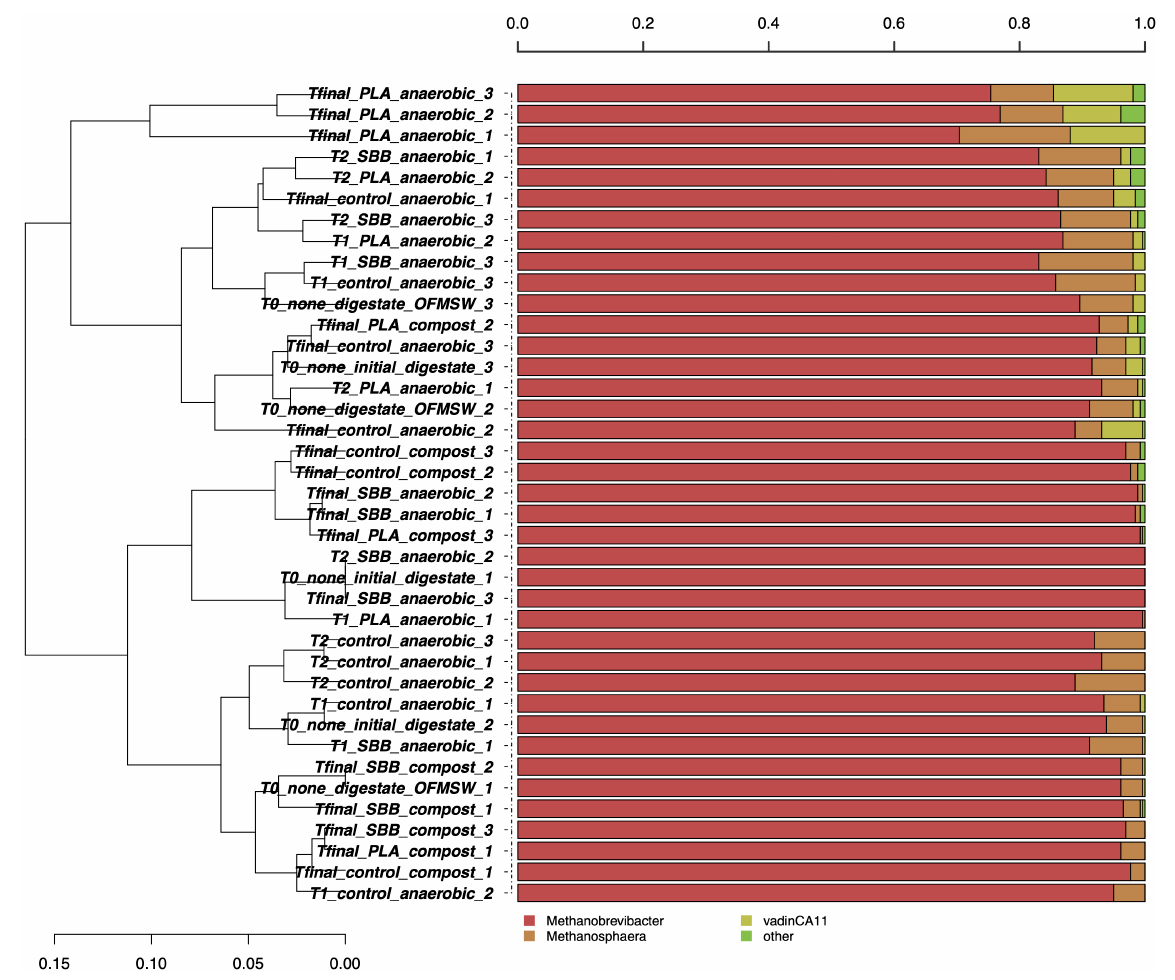
FIGURE2 Hierarchical clustering of archaeal sequences using the average linkage algorithm at the genus level for taxa with at least ≥ 5% participation in a single sample. Taxa with low contributions were added to the “other” group. PLA, polylactic acid; SBB, starch-based bioplastic; OFMSW, organic fraction of municipal solid